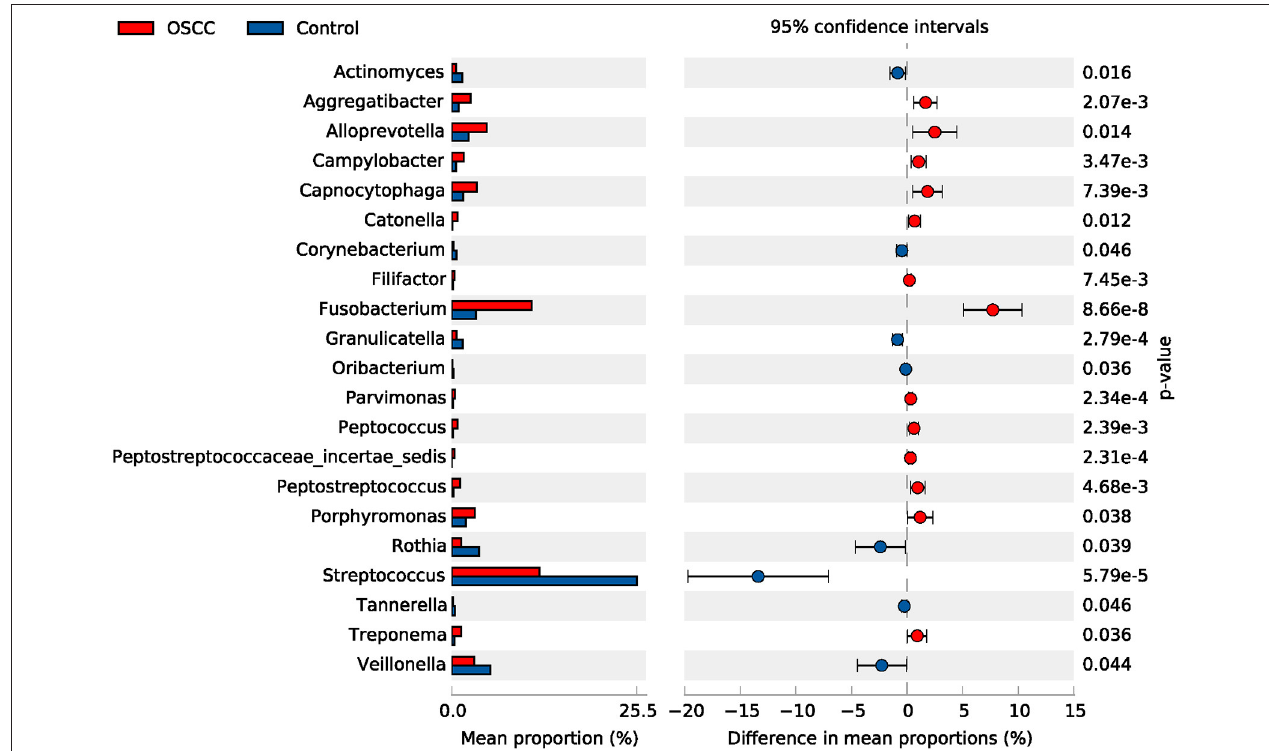
FIGURE 3 | Comparative taxonomic profile of the OSCC and Control groups at genus level. The genera with significant richness difference ( P < 0.05, computed by STAMP) between the two groups are shown.